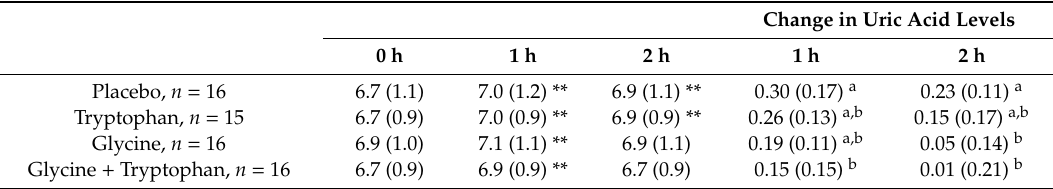
Table 3. Changes of serum uric acids concentrations (mg / dL) in the crossover trial.